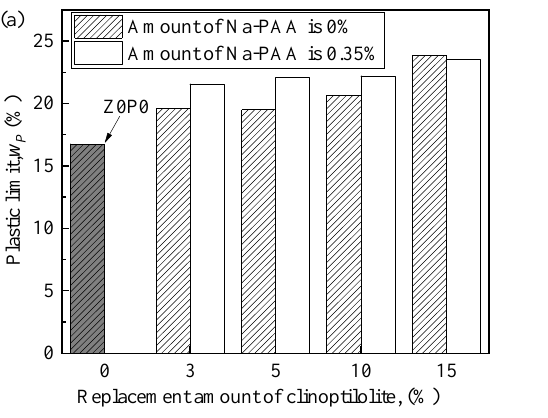
Figure 9. The Atterberg limits. ( a ) Plastic limit; ( b ) Liquid limit.